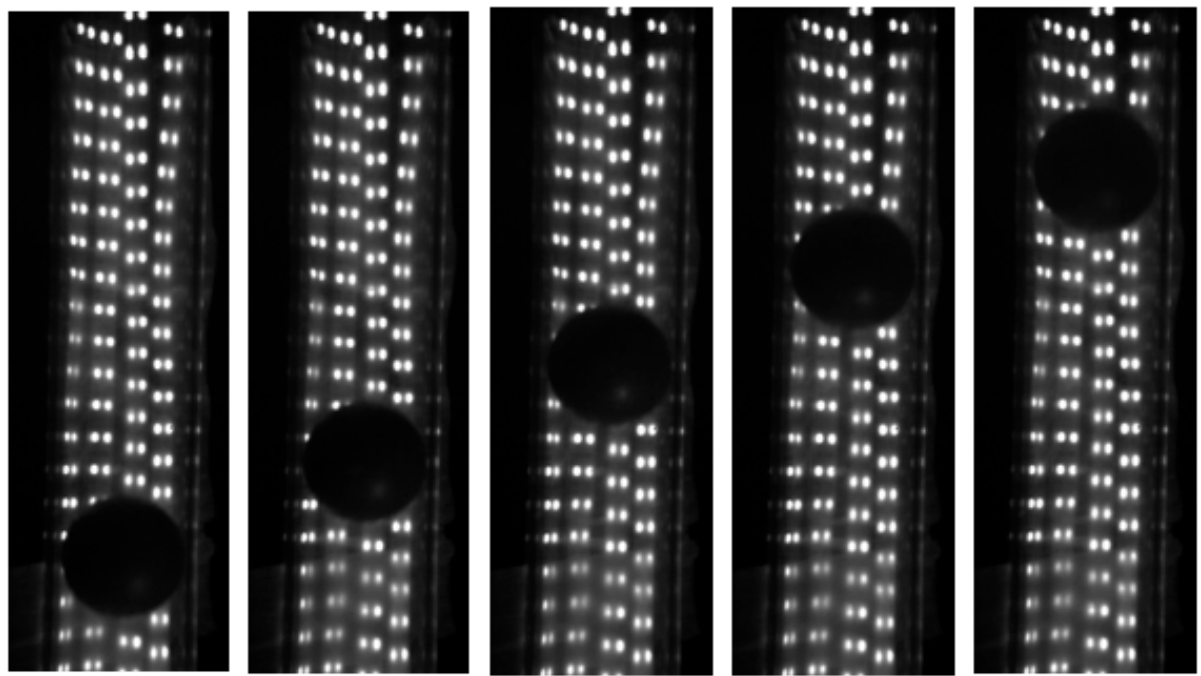
Figure 11. Motion image of the simulated parts.